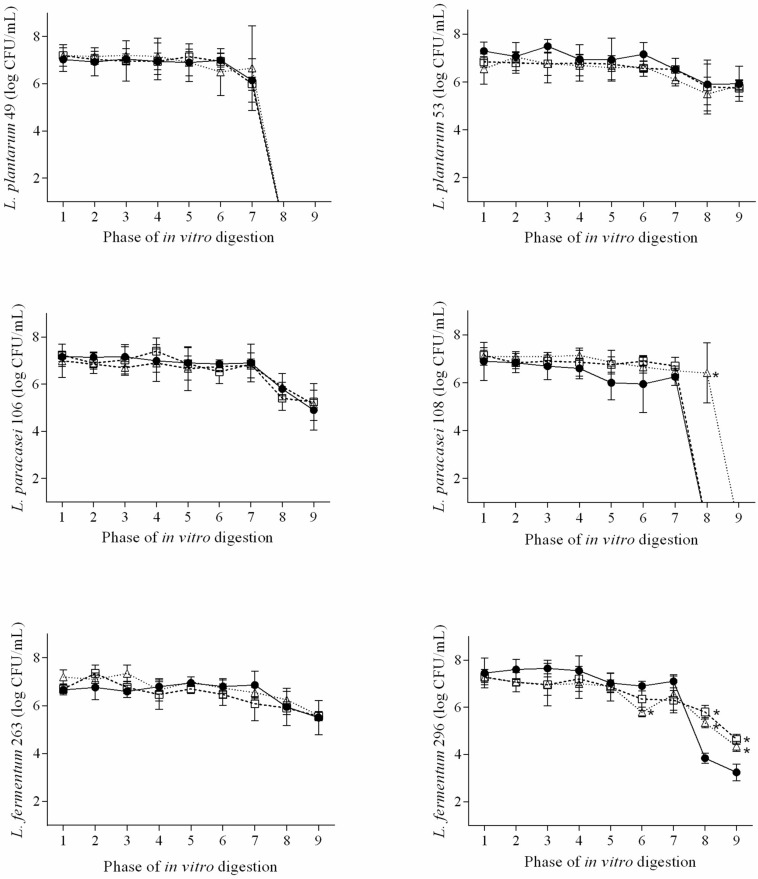
Viable cell counts (n = 9; average ± standard deviation; log CFU/mL) of L. plantarum 49, L. plantarum 53, L. paracasei 106, L. paracasei 108, L. fermentum 263, and L. fermentum when exposed to the different phases of a simulated gastrointestinal digestion in de Mann, Rogosa and Sharpe (MRS), MRS with 1/2 MIC of QUE (MRS + QUE), and MRS with 1/2 MIC of RES (MRS + RES). The error bars represent the standard deviations. Phase 1, mouth conditions, pH 6.9, and exposure time 2 min; phase 2, esophagus-stomach conditions, pH 5.5, and exposure time 12 min; phase 3, esophagus-stomach conditions, pH 4.6, and exposure time 22 min; phase 4, stomach conditions, pepsin, pH 3.8, and exposure time 32 min; phase 5, stomach conditions, pepsin, pH 2.8, and exposure time 52 min; phase 6, stomach conditions, pepsin, pH 2.3, and exposure time 72 min; phase 7, stomach conditions, pepsin, pH 2, and exposure time 92 min; phase 8, duodenum conditions, pancreatin + bile salts, pH 5, and exposure time 122 min; and phase 9, ileum conditions, pH 6.5, and exposure time 182 min. ∗, means difference (p ≤ 0.05) of the viable cell count of the tested strain in the respective phase of in vitro digestion when compared to the control, based on Tukey’s test.